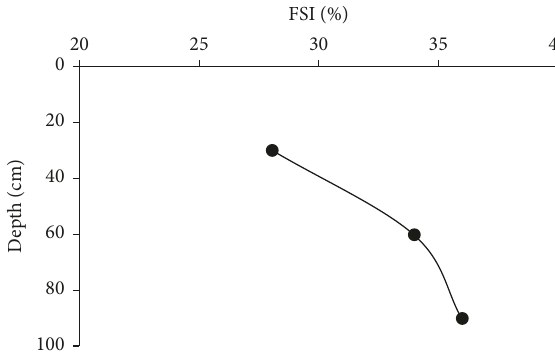
Figure 11: Free swell index at different depths.